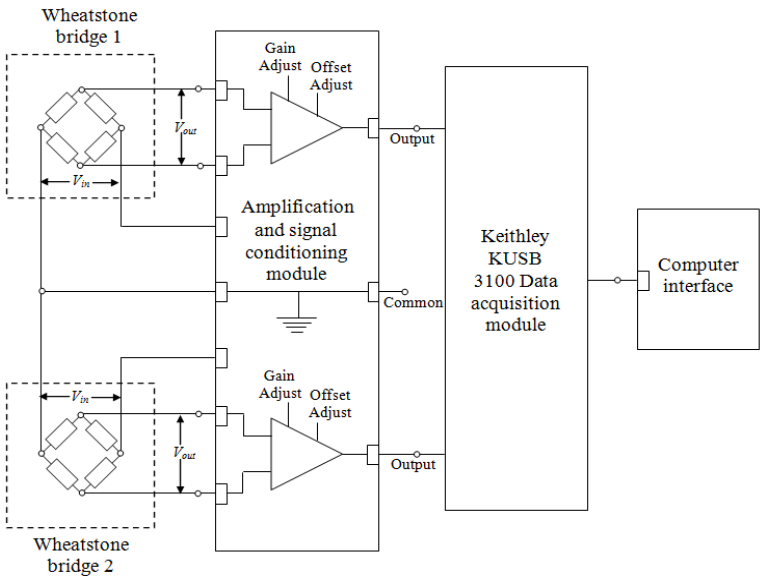
Figure 9. Schematic diagram of instrumentation amplifier and data acquisition module connected to sensors in Wheatstone bridge configuration.